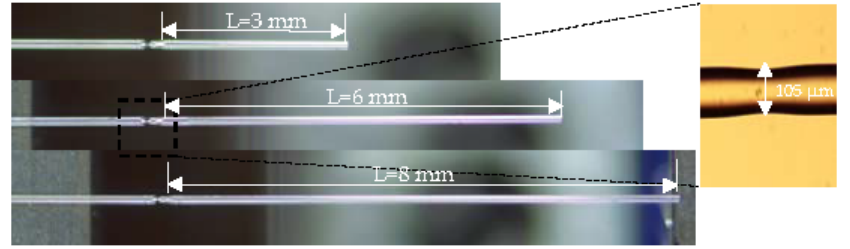
Figure 3. Microscope image of the taper structure of MI with different lengths and enlarged view of the taper.